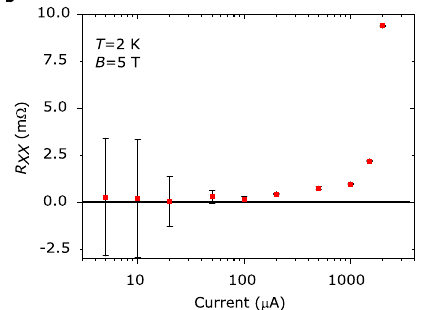
Fig. 3 | Characterization of single Hall bar. a A separate Hall bar with a normal rectangular geometry is used to measure longitudinal resistance R XX (red) and transverse resistance R XY (blue). The device is fully quantized for B>3T, and the longitudinalresistancevanishesbelowthenoiselevelof~100nV.Fromthelow- fl ux densitymeasurementofthetransverseresistance,thecarrierdensityisdetermined to be n =1.7×10 11 cm − 2 and mobility is μ = 19,600cm 2 V − 1 s − 1 . Since all quantum Hall devicesarelocatedonthesamechip,thisalsoprovidesanindirectmeasurementof